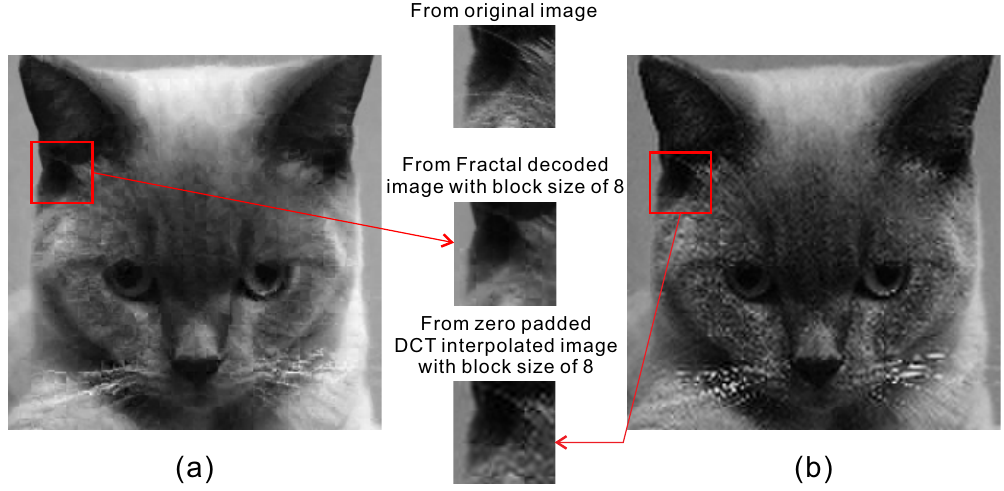
Figure 4. Comparison of Cat image of size 256 × 256 by ( a ) fractal decoding with 20 iterations and ( b ) zero padded DCT interpolation with only the low frequency 4 × 4 DCT coefficients block being retained, where the same block size of 8 × 8 is adopted in both